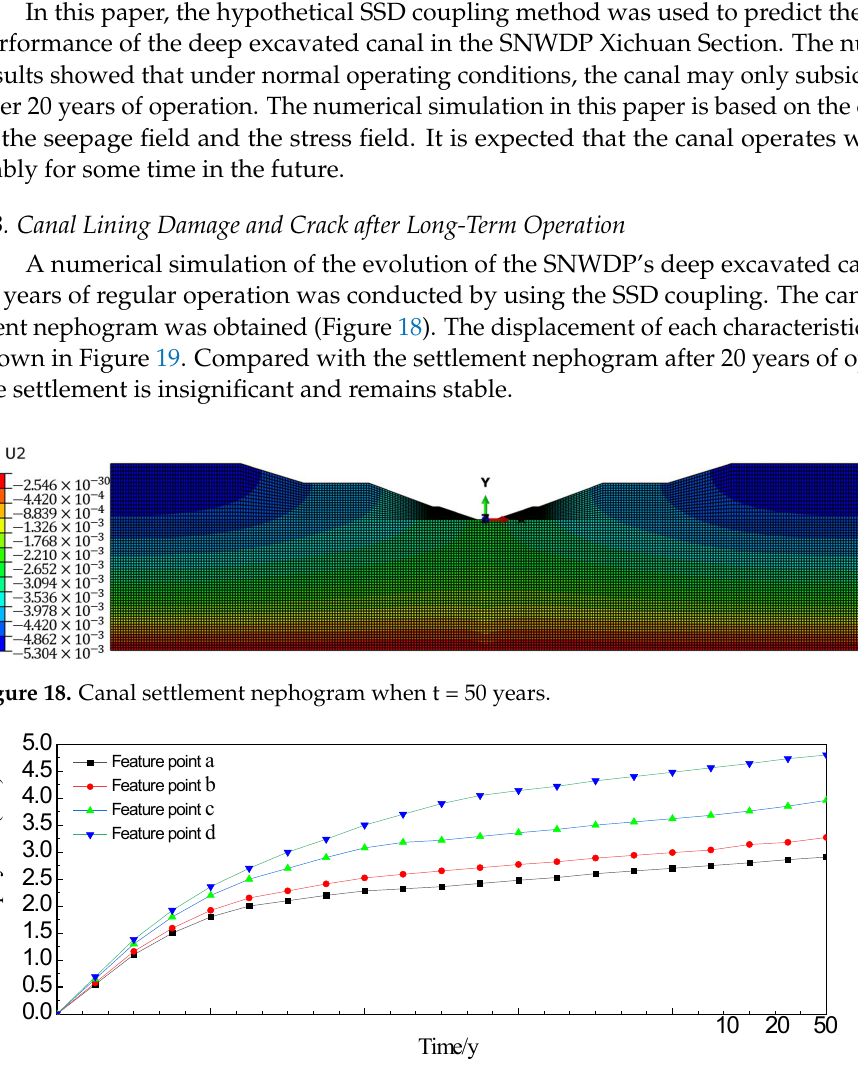
Figure 17. Settlement of each characteristic point when t = 20 years.